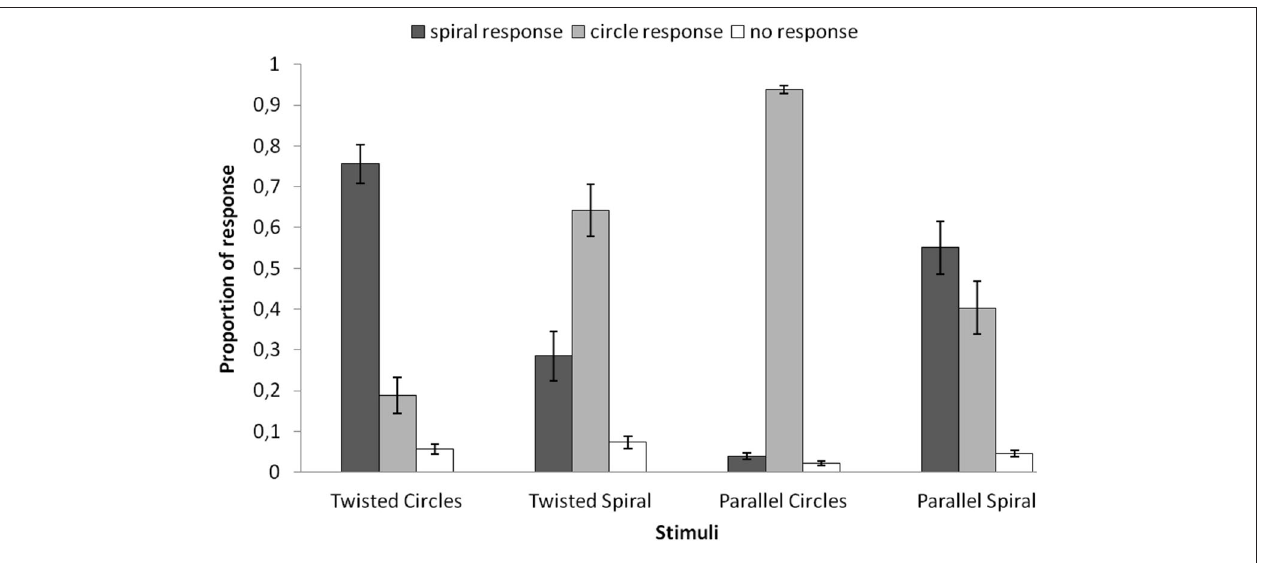
were also significantly different between the Twisted Spiral and the Parallel Circles, the Twisted Spiral and the Parallel Spiral, the Parallel Circles and the Parallel Spiral. Error bars represent the standard error of the mean.